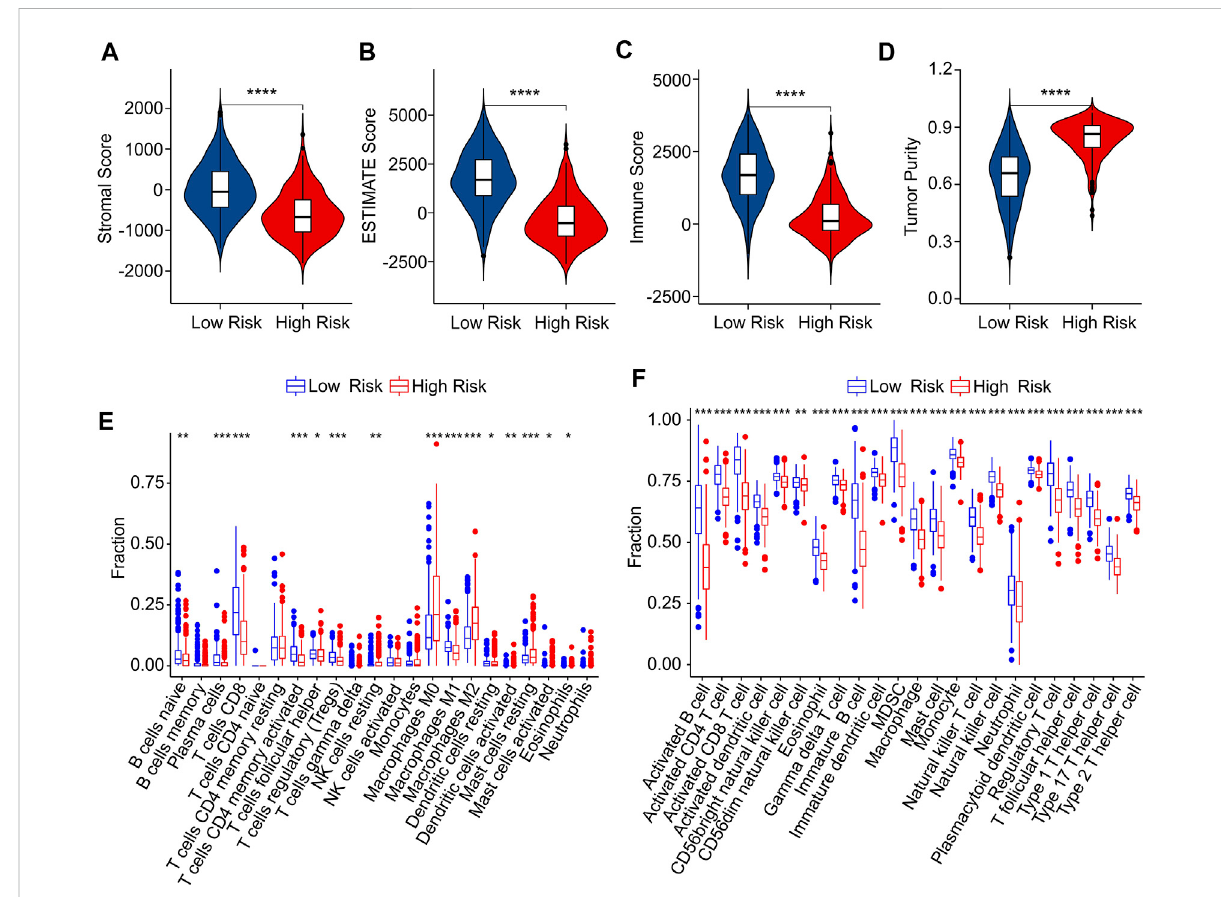
FIGURE 8 Immunein fi ltrationlandscapeanalysisofCMpatientsinlow-andhigh-riskgroup. (A) Stromalscore. (B) ESTIMATEscore. (C) Immunescore. (D) Tumorpurity. (E) Thefractionof22immunecellsinlow-andhigh-riskgroupcalculatedbyCIBERSORTalgorithm. (F) Thefractionof23immunecells low- and high-risk group calculated by ssGSEA